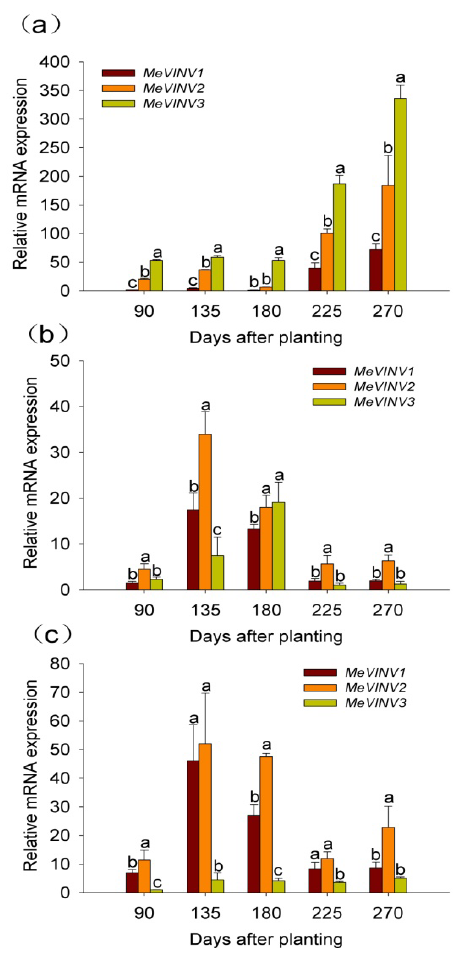
Figure 10. Expression profiles of MeVINVs in leaves ( a ), tuber phloem ( b ) and tuber xylem ( c ) at tuber developmental stages in cassava. The amount of MeVINV mRNA was normalized by the tubulin mRNA, and the expression of MeVINV3 in tuber xylem at 90 days was used as a calibrator. Each value is the mean ± SE of three independent biological replicates. Letters on the error bars indicate the significant difference from each gene by ANOVA analysis ( p <